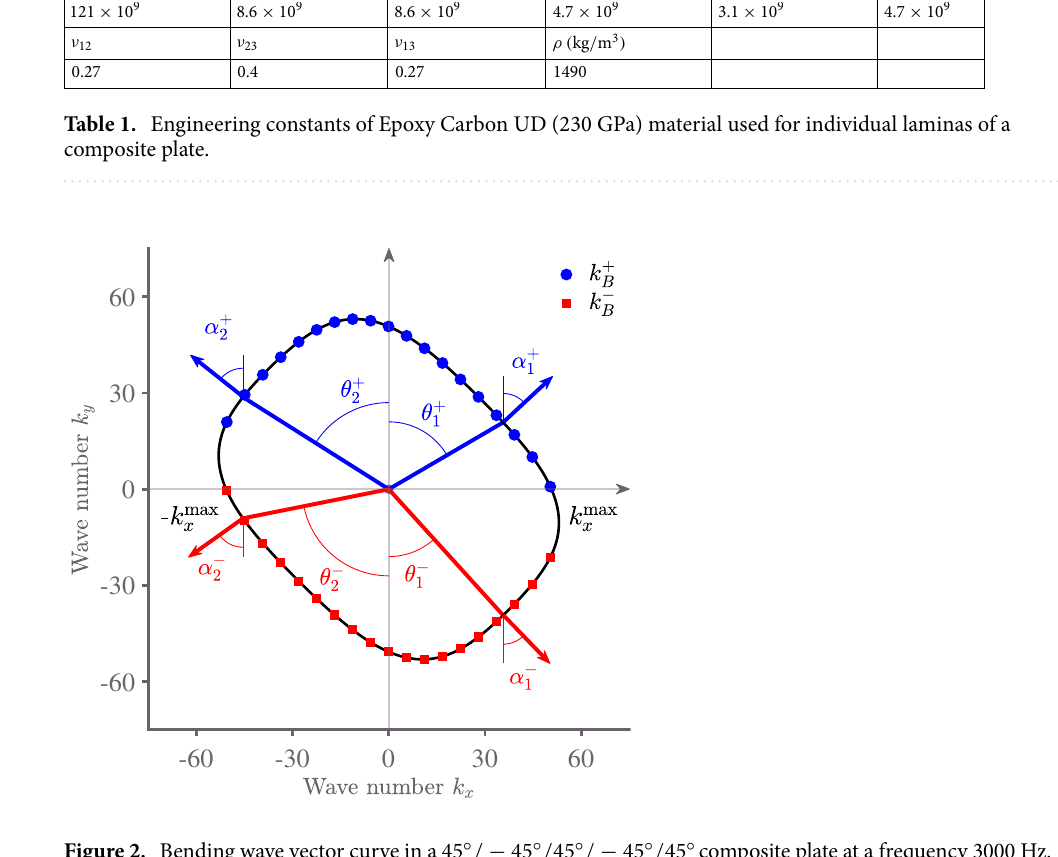
Figure 2. Bending wave vector curve in a 45 ◦ / − 45 ◦ / 45 ◦ / − 45 ◦ / 45 ◦ composite plate at a frequency 3000 Hz. Blue dots represent wave numbers related to outgoing waves while red squares correspond to incoming waves. Angles α 1 ( 2 ) and θ 1 ( 2 ) represent group and wave vector or phase angles, respectively. The wave number component k max x is equal to 53m − 1 . Material parameters of orthotropic layers are from Table 1.